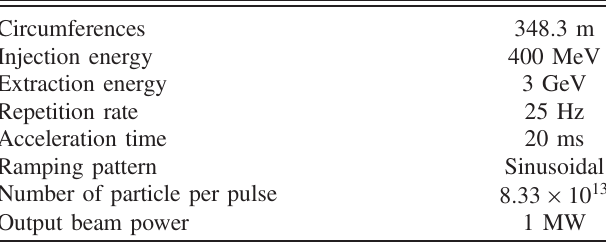
TABLE I. Design parameters of the J-PARC RCS [3].